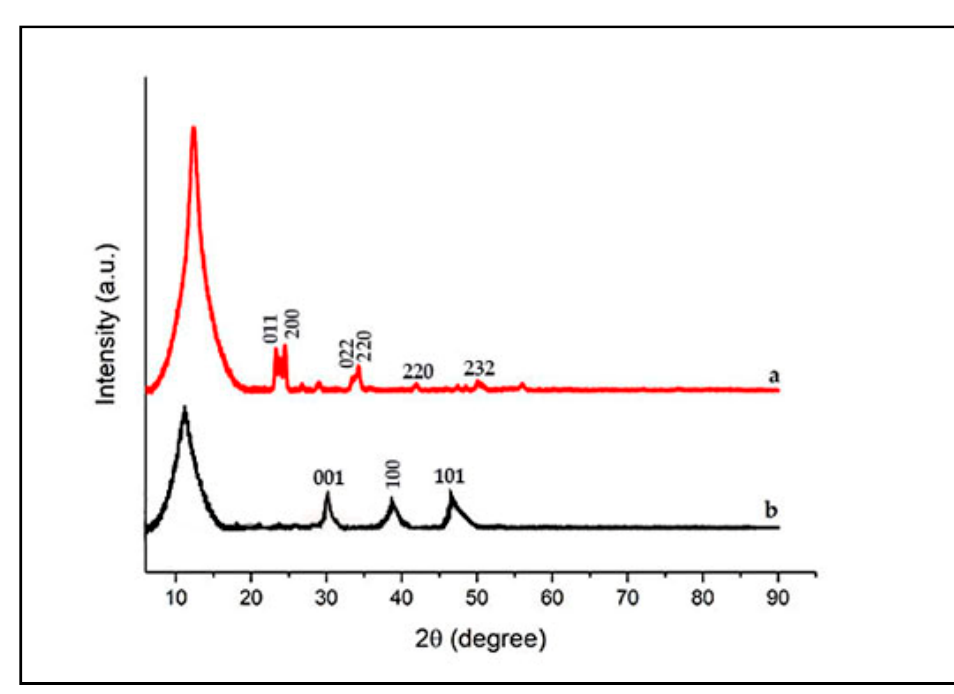
Figure 6. XRD patterns of WO 3 /GO ex situ synthesis (a) and WO 3 /GO in situ synthesis (b). A low intensity peak at 10.8 ◦ indicates the formation of GO sheets in the in situ synthesis of WO 3 /GO, which is due to the poor crystalline nature of carbon. The other peaks at 2 θ values of 23.3, 24.5, 34.2, 42.1, 47.49, and 50.22 confirm the presence of WO 3 particles [39]. The WC diffraction spectrum shows three major intense peaks located at 2 θ = 30.42 ◦ , of WC, respectively